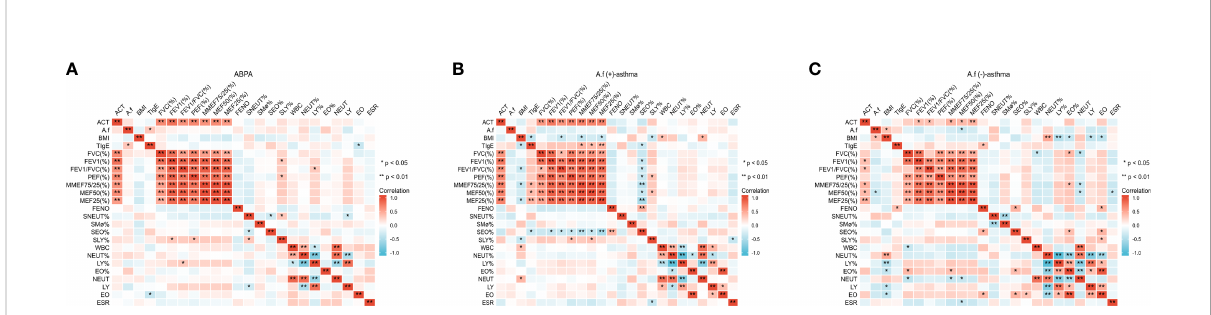
FIGURE 6 IL-33, IL-25, and TSLP levels in different groups. (A) IL-33, IL-25, and TSLP levels in ABPA group; (B) IL-33, IL-25, and TSLP levels in A.f (+) asthma group; (C) IL-33, IL-25, and TSLP levels in A.f ( − ) asthma group. IL-33, interleukin 33; IL-25, interleukin 25; IL-17E, interleukin 17E (can be as IL-25); TSLP, thymic stromal lymphopoietin; ABPA, allergic bronchopulmonary aspergillosis; A.f (+) asthma, Aspergillus fumigatus -sensitized asthma; A.f ( − ) asthma, non- Aspergillus fumigatus -sensitized asthma. *p<0.05 and